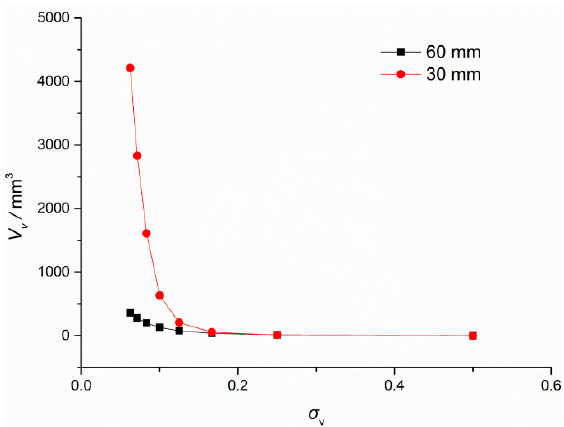
Figure 14. Total vapor volumes inside the valve for different cavitation index with the valve core displacement of 60 mm and 30 mm.